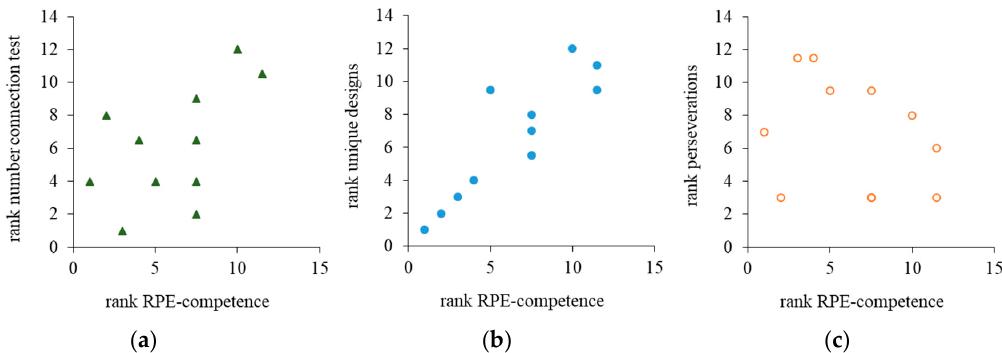
Figure 3. Rank correlations between rating of perceived effort (RPE) competence, performance time in the Number Connection Test ( a ), unique designs ( b ) and perseveration errors ( c ) in the Five-Point Test.